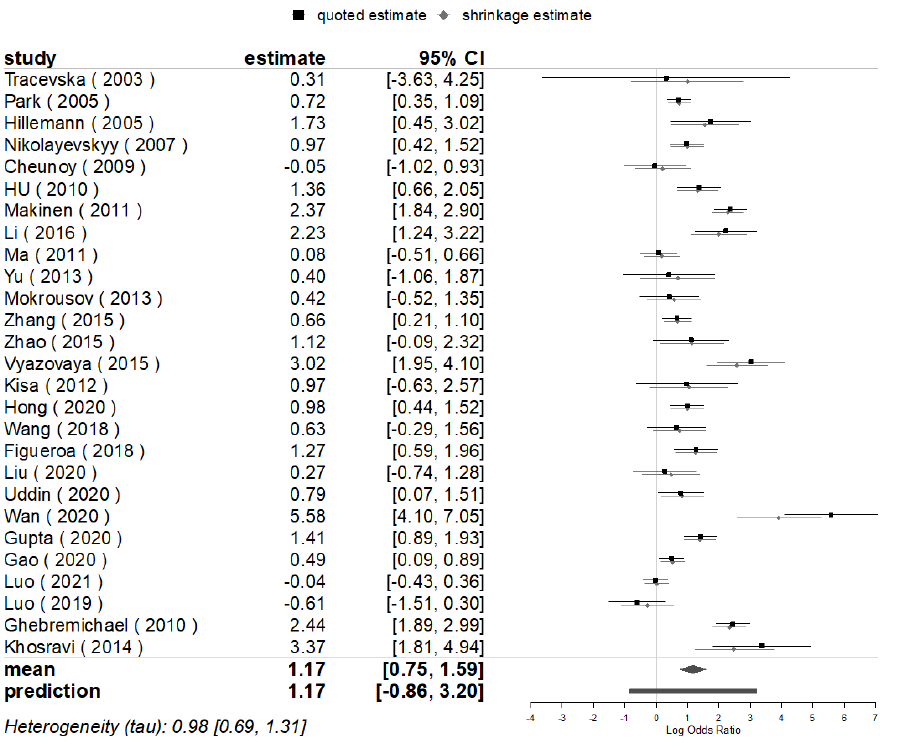
Genes 2022 , 13 , x FOR PEER REVIEW Figure 5. BMA for the mutations of katG in Beijing and non-Beijing strains. Figure 5. BMA for the mutations of katG in Beijing and non-Beijing strains.